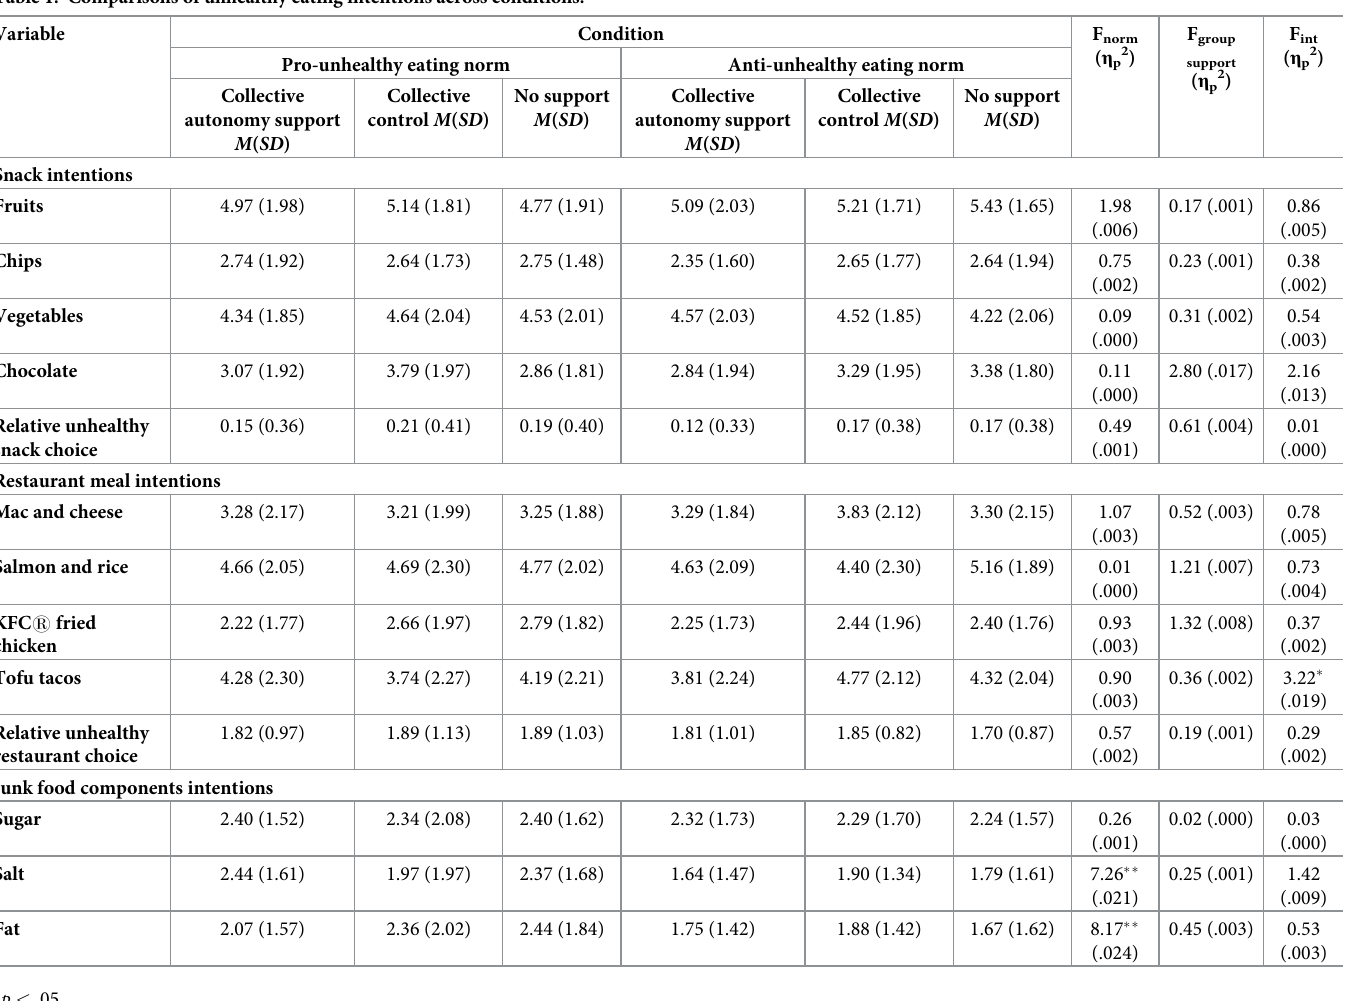
Table 1. Comparisons of unhealthy eating intentions across